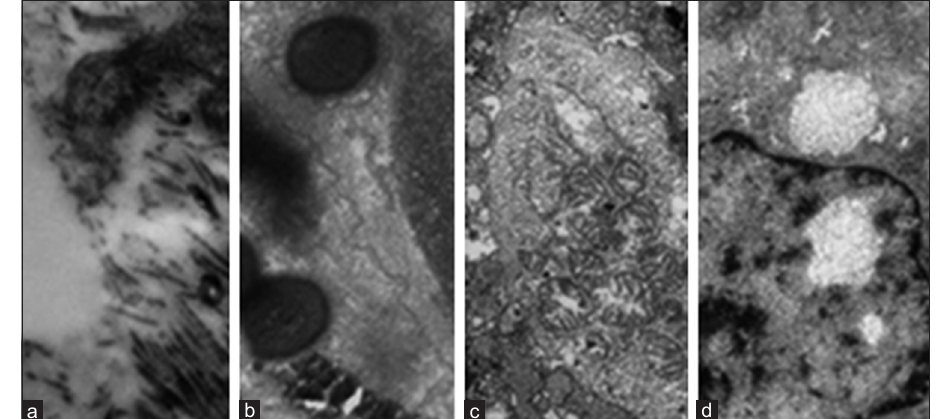
Figure-2: Ultrastructural changes in endometrial cells in acute postpartum endometritis in cows: (a) Destruction of microvilli on the apical surface of the epithelium, (b) abundance of coccal microflora on the surface of the epithelium, (c) necrobiosis of epithelial cells, (d) partial edema of the nucleus and cytoplasm of the histiocyte. Magnification: (a) 3500, (b) 5600, and (c and d)